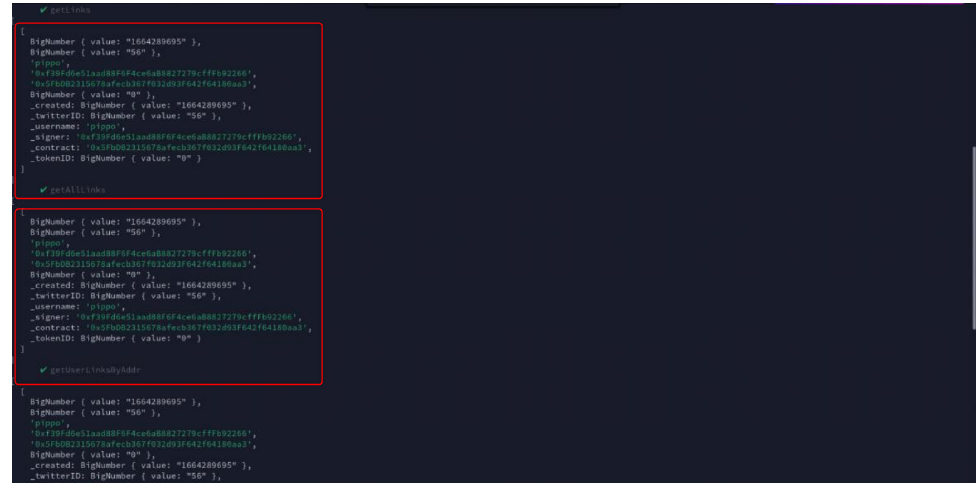
Figure 12. TwitterLink contract testing: getAllLinks and